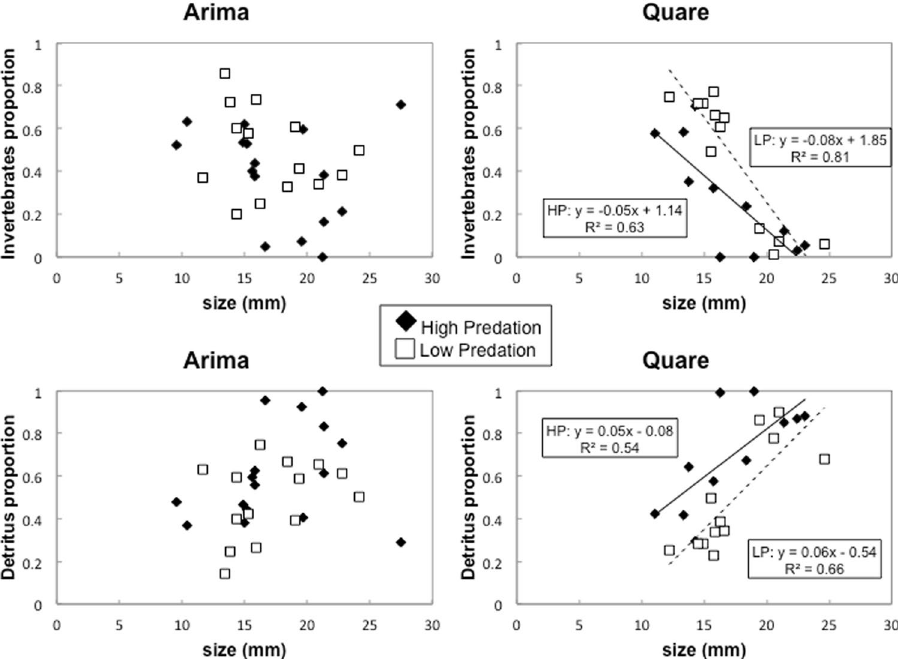
Figure 3. Relationship between fish length and proportion of invertebrates and detritus in diet from the Arima and Quare rivers. Only significant relationships are shown. HP guppies: filled symbols; LP guppies: open symbols.